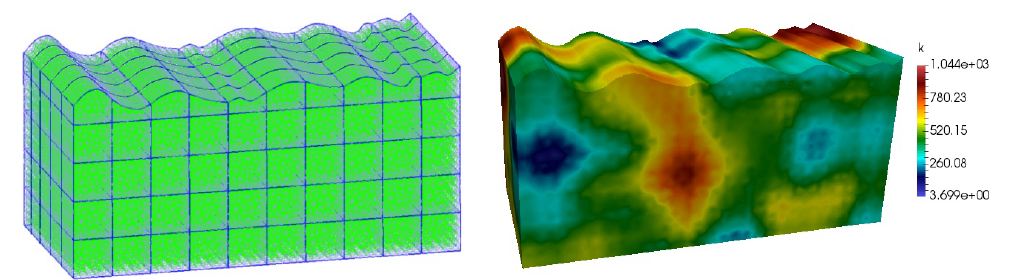
Figure 6. Computational grids and heterogeneous properties for Tests 3.DBC, 3.NBC, 3.RBC (three-dimensional problem). Left : Coarse grid (blue color) and fine grid (green color). Right : Heterogeneous coefficient k s ( x ) .